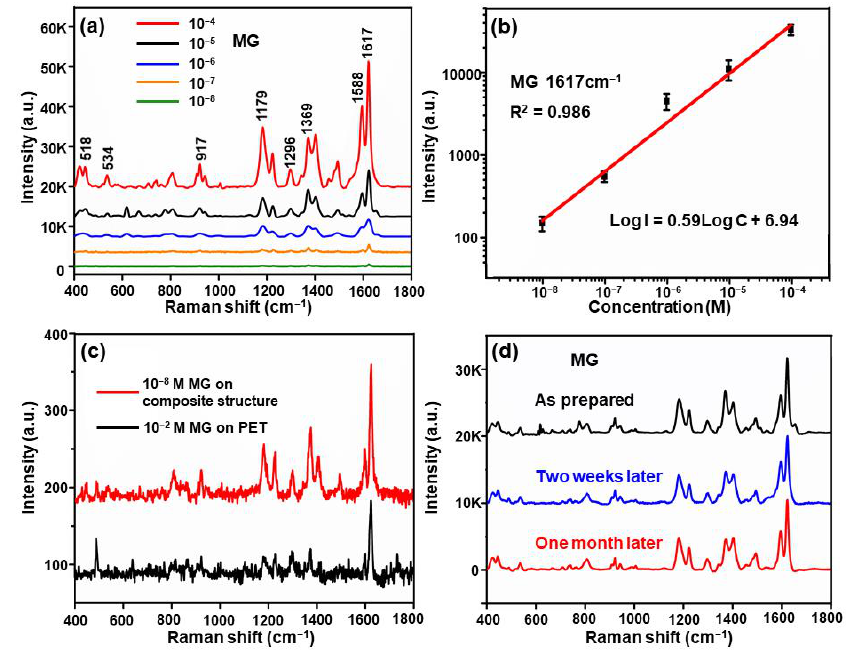
Figure 7. ( a ) SERS spectra acquired from 10 −4 to 10 −8 M malachite green (MG) deposited on the composite structure substrate displaying six Au/Al 2 O 3 bilayers. ( b ) The calibration curve of the normalized Raman intensity at 1617 cm −1 versus MG of different concentrations. Error bars indicate standard deviations from 10 spectra. ( c ) The Raman spectra for 10 −8 M MG collected for the composite structure, and 10 −2 M obtained for PET for comparison. ( d ) The long-term stability for the MG SERS spectra collected from the composite structure substrate stored for the different periods.